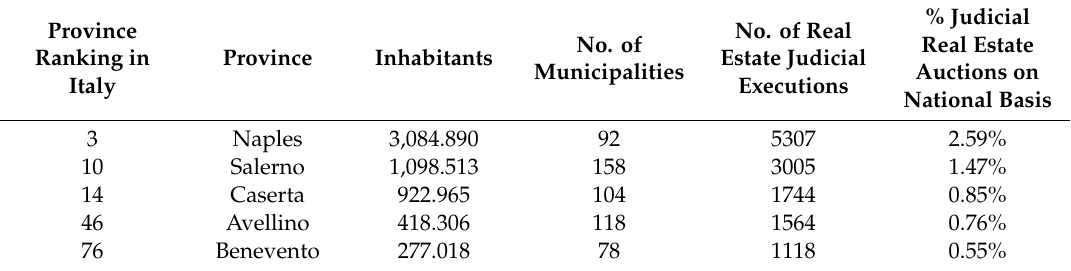
Table 3. Number of real estate auctions in the provinces of the Campania region (year